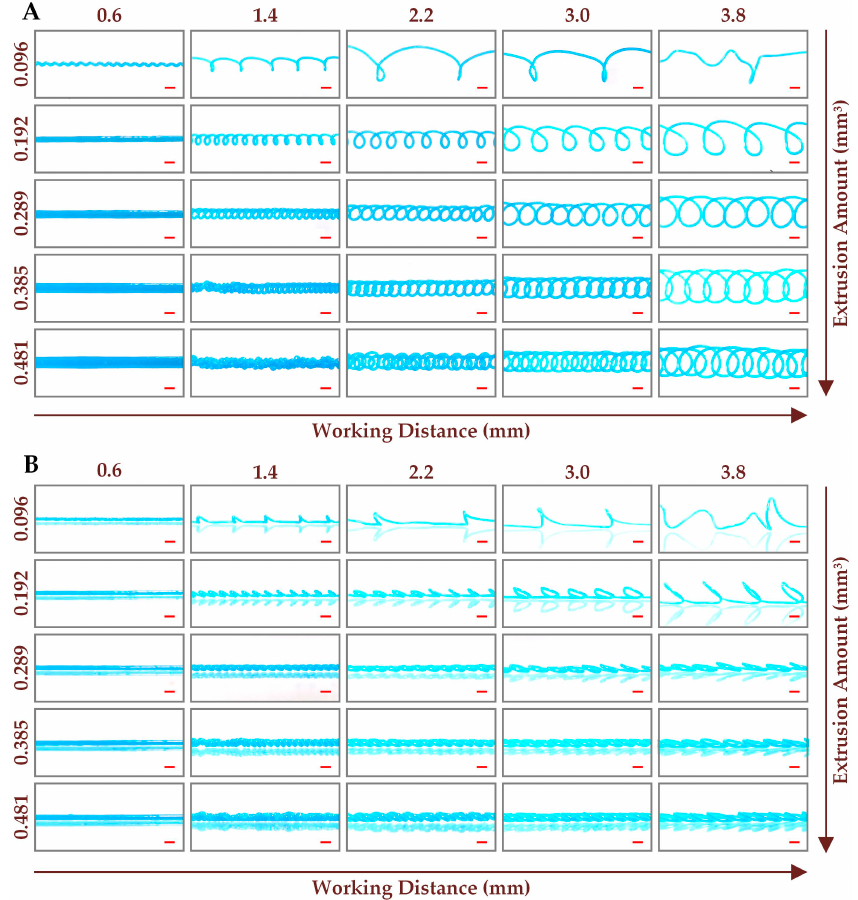
Figure 5. Optical photos of the printed channel molds at di ff erent working distances and extrusion amounts with the printing speed fixed at 200 mm / min from vertical view ( A ) and side view ( B ). The red scale bar represents 1